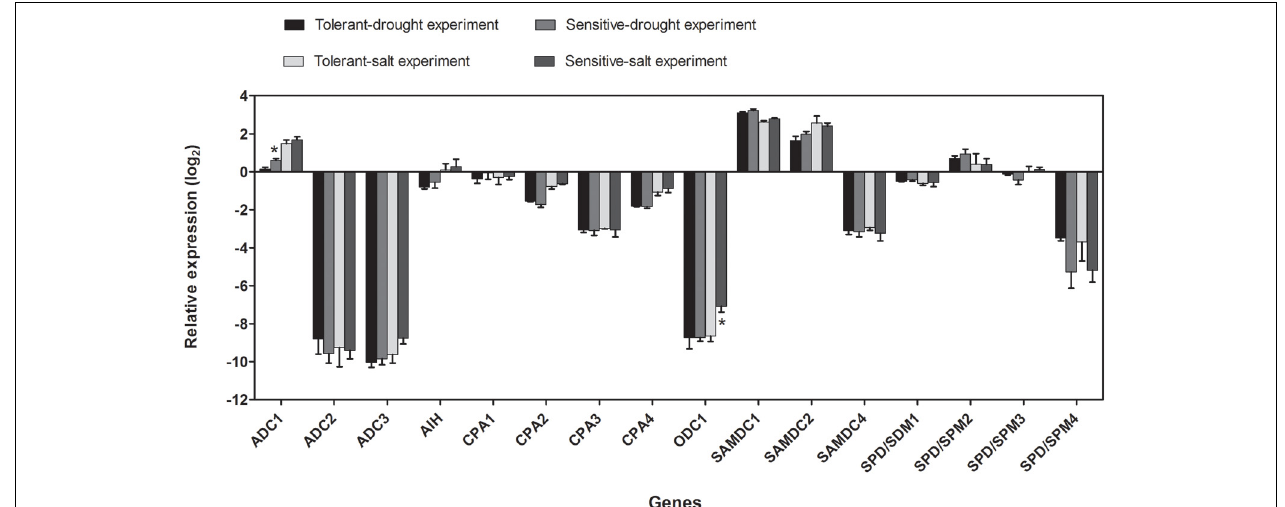
FIGURE 7 | Relative average expression (log 2 ) of genes encoding enzymes involved in polyamine biosynthesis under control conditions in three tolerant vs. sensitive cultivars used in drought and salt stress experiments. Relative gene expression (log 2 ) in comparison to the housekeeping genes is shown for drought- and salt-tolerant (52, 4, 1) and